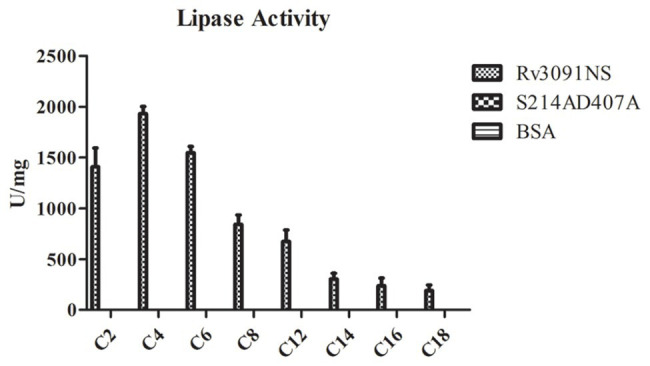
Lipase activity of Rv3091NS towards p-nitrophenol (pNP) with various chain lengths. C2: pNP-acetate, C4: pNP-butyrate, C8: pNP-caprylate, C10: pNP-capricate, C12: pNP-laurate, C14: pNP‐ myristate, C16: pNP-palmitate, C18: pNP‐ stearate. Mean ± SEMs (n = 3).